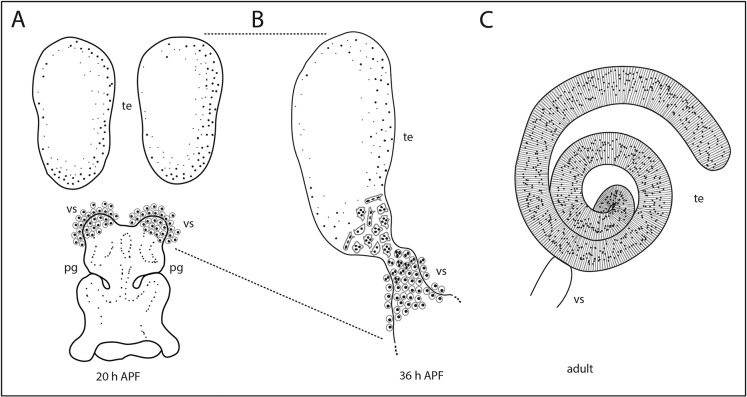
Scheme of the origin and development of the testes muscles. (A) Genital disc 20 h after puparium formation (APF) contains a pool of myoblasts on the protruding seminal vesicles (vs). The paired testes (te) are free of myoblasts. (B) By 36 h APF, the testis and the developing seminal vesicle are fused. Multinucleated nascent myotubes migrate onto the testis. (C) The adult testis is surrounded by a sheath of multinuclear smooth-like muscles. Modified after Bodenstein (1950); Susic-Jung et al. (2012).